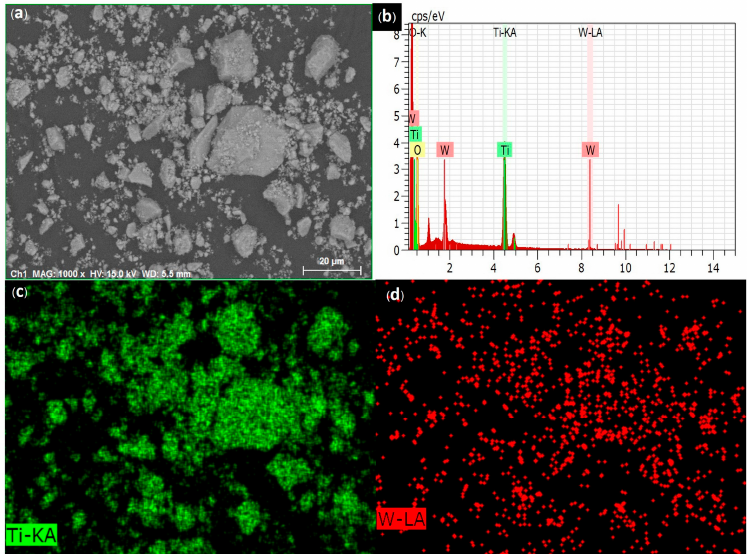
Figure 3. SEM image ( a ), EDX spectrum ( b ), and EDX dot maps ( c , d ) of the composite metal oxides (10% WO 3 @TiO 2 ).